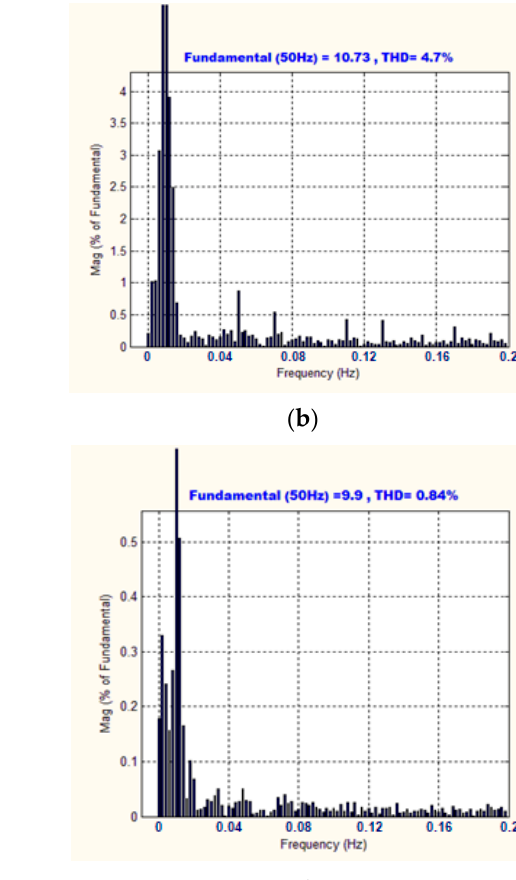
Figure 14. Source current THD with ( a ) PI ( b ) Fuzzy ( c ) ANN without genetic algorithm (GA)–RBFNN ( d ) ANN incorpo- rated with GA–RBFNN.